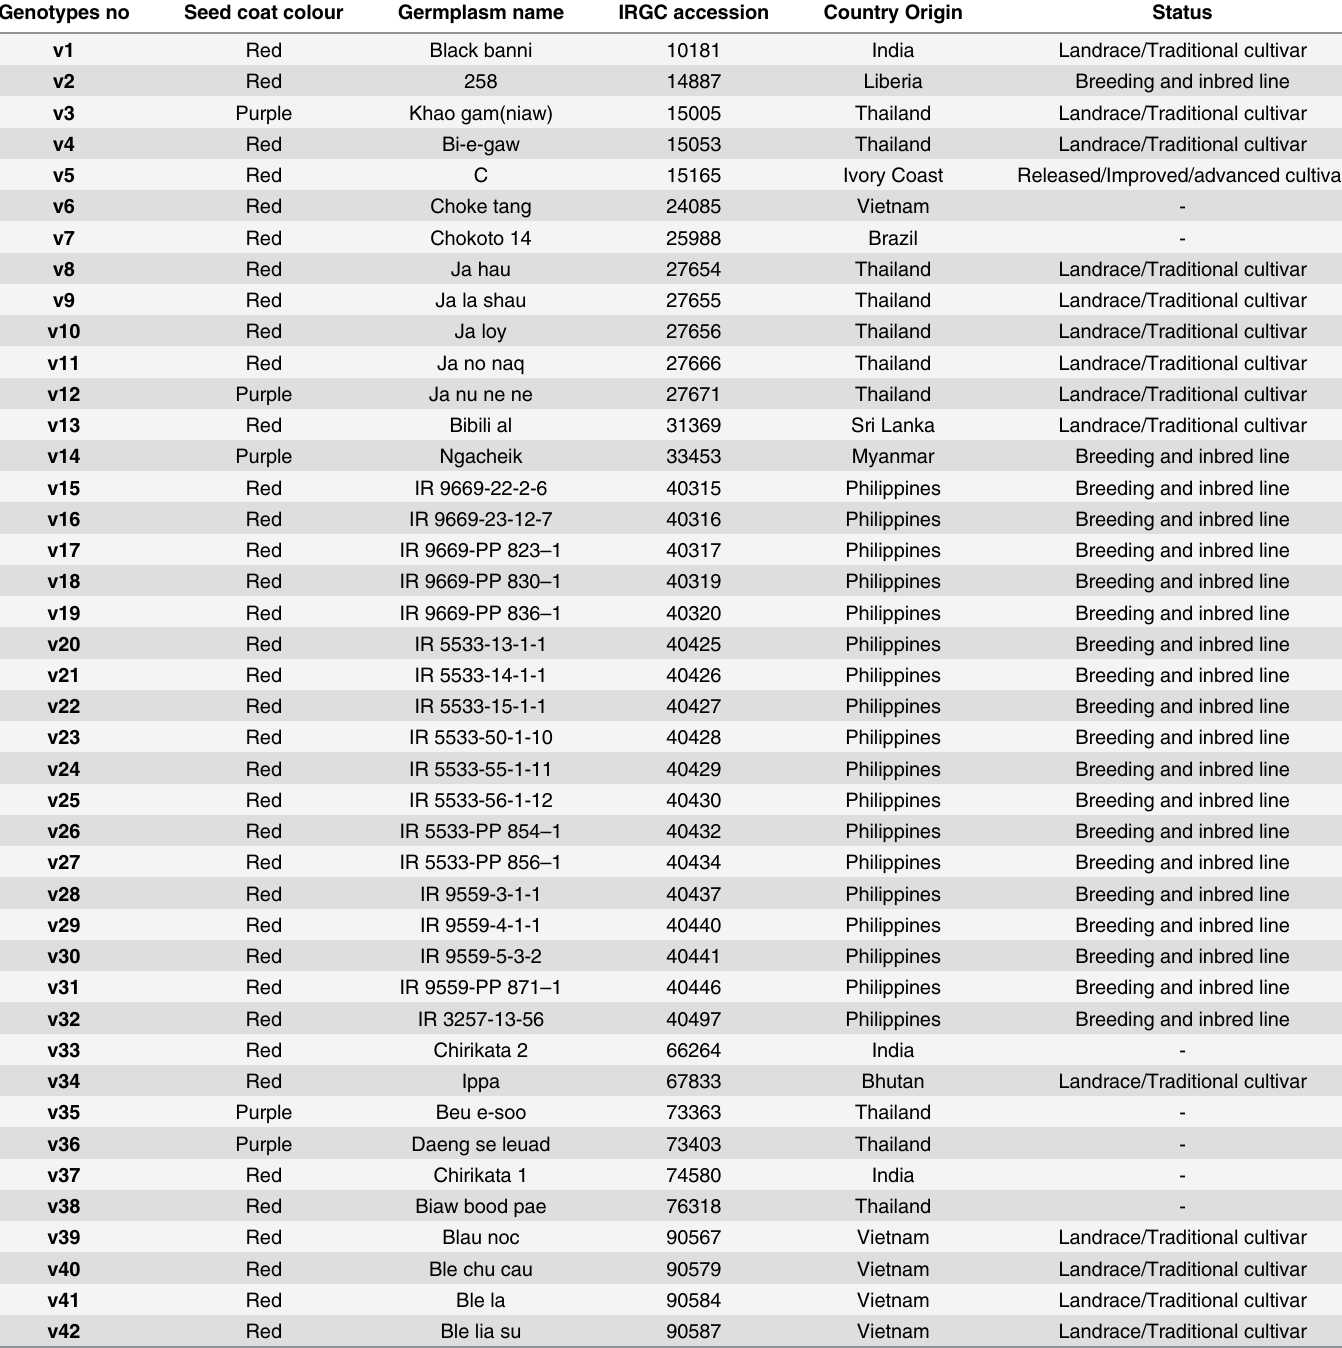
Table 1. List of selected coloured upland rice genotypes. Genotypes